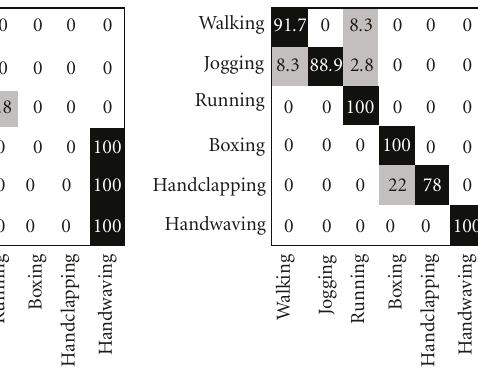
(a) Results with histogram intersection (b) Results with Gaussian kernel as a (c) Results with our proposed kernel k HC , kernel as a positive definite kernel with characteristic kernel with overall accuracy with overall accuracy rate of 93.1% overall accuracy rate of 85.3% rate of 33.8% Figure 8: Confusion matrices obtained on the KTH dataset with F2 descriptors [19], using SVM and the indicated kernels; (a) shows the rec with recognition rates of histogram Intersection kernel which is a positive definite but not a characteristic kernel; (b) denotes the result of a characteristic kernel (Gaussian) which is not tailored for histogram based information; (c) is the result of characteristic kernel which is tailored for